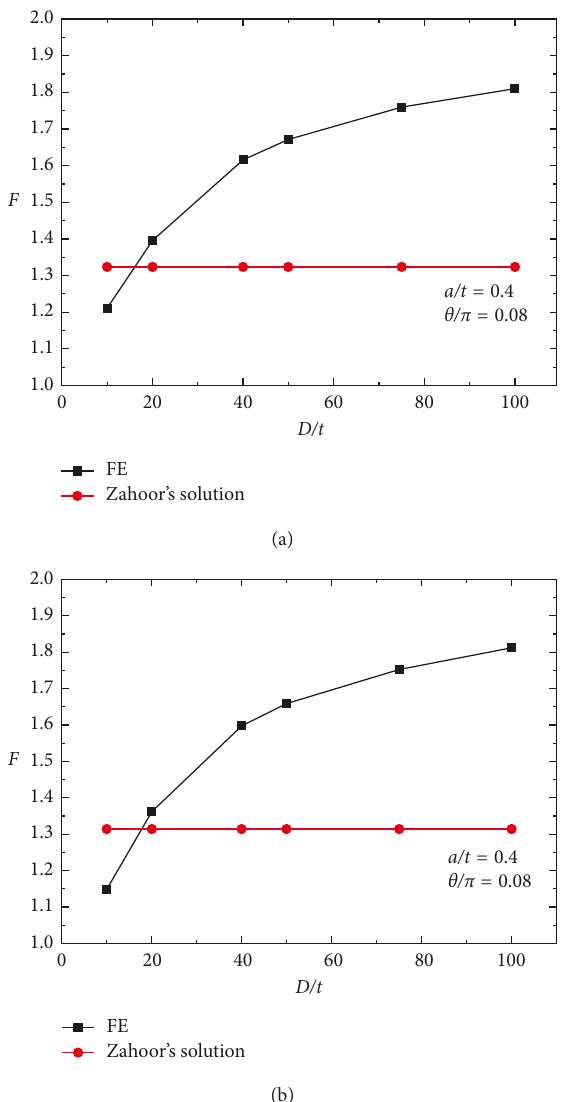
Figure 3: Comparison of F values for pipes with a / t θ / π 0.08: (a) tension; (b) bending. (cid:31)